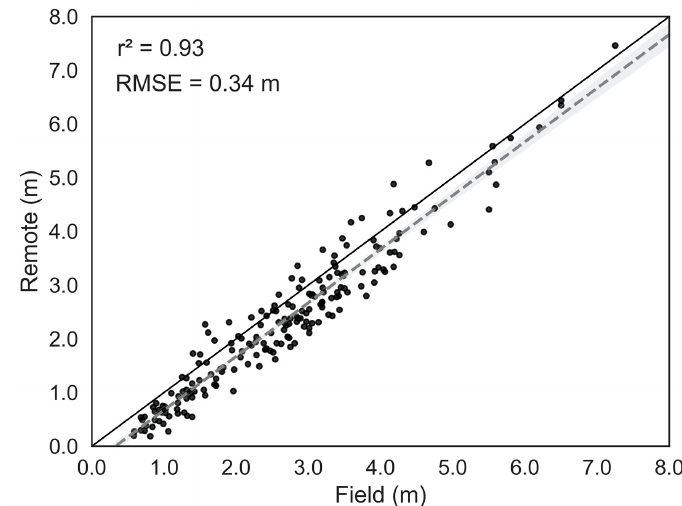
Figure 9. Simple linear regression for field and remote height measurements. The black line represents a 1:1 match, while the dotted grey line represents the trend of the relationship between field and remote height measurements. With 95% confidence, error is between − 0.38 m and − 0.28 m, based on 194 samples. Median error was closer to zero for lodgepole pine individuals than it was for white spruce individuals across all height classes (Figure 10a). However, lodgepole pine error was less consistent than white spruce error, which is demonstrated by greater interquartile ranges for lodgepole pine across all height classes (Figure 10a). The 1st and 3nd height classes contained the closest median error values to zero for white spruce and lodgepole pine, respectively (Figure 10a). The difference in median error between the lodgepole pine and white spruce distributions was greatest at the 5th